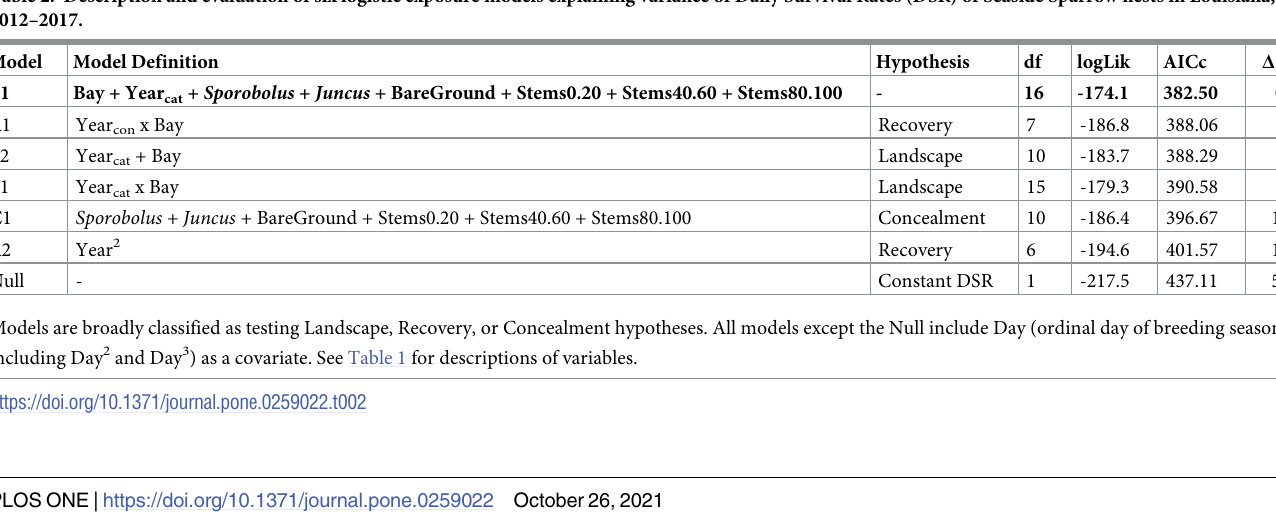
Table 1 for variable descriptions) varied between nest (coded as 1) and random points (coded as 0). We considered variables statistically significantly associated with nest placement if esti- mated 95% confidence intervals for their parameter estimates did not include 0.